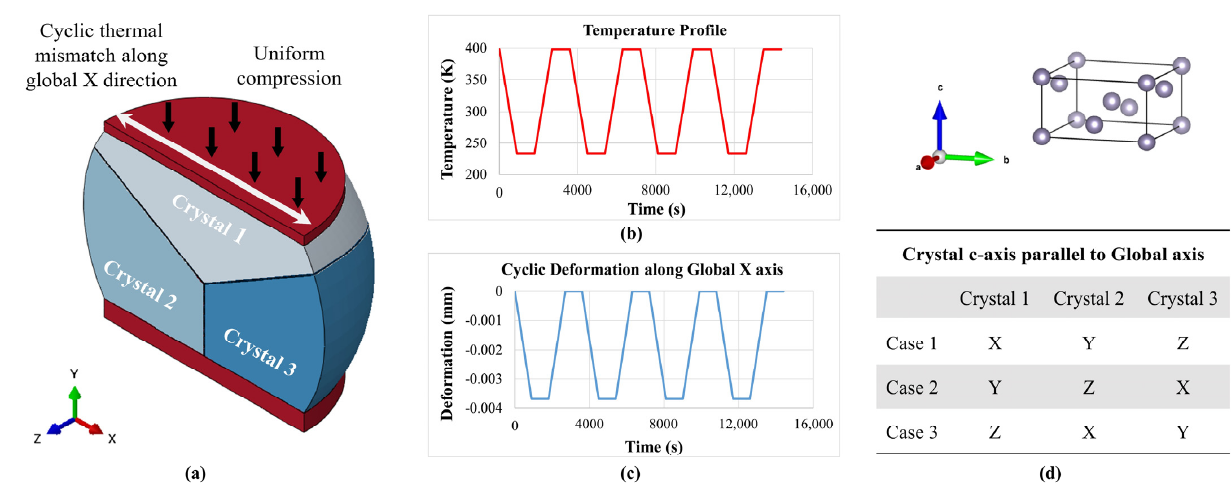
Figure 11. Typical tricrystal BGA joint: ( a ) geometry and loading condition; ( b ) temperature profile; ( c ) cyclic horizontal deformation and ( d ) three combinations of crystal orientations.